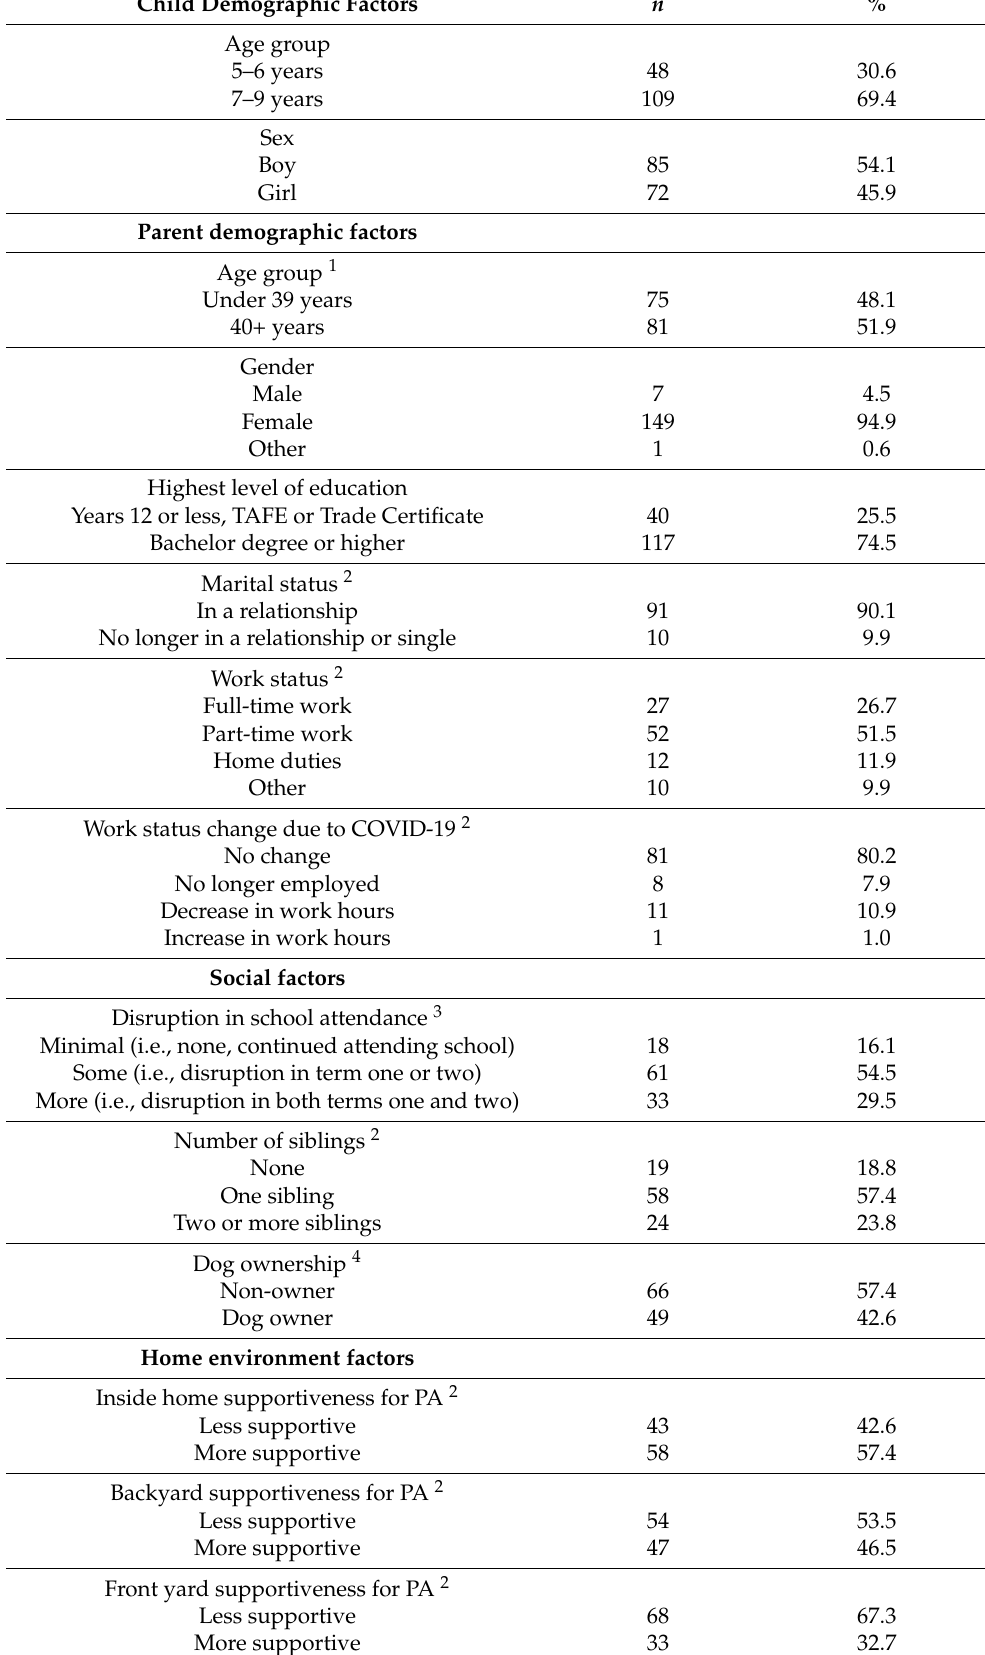
Table 1. Sample characteristics ( n =